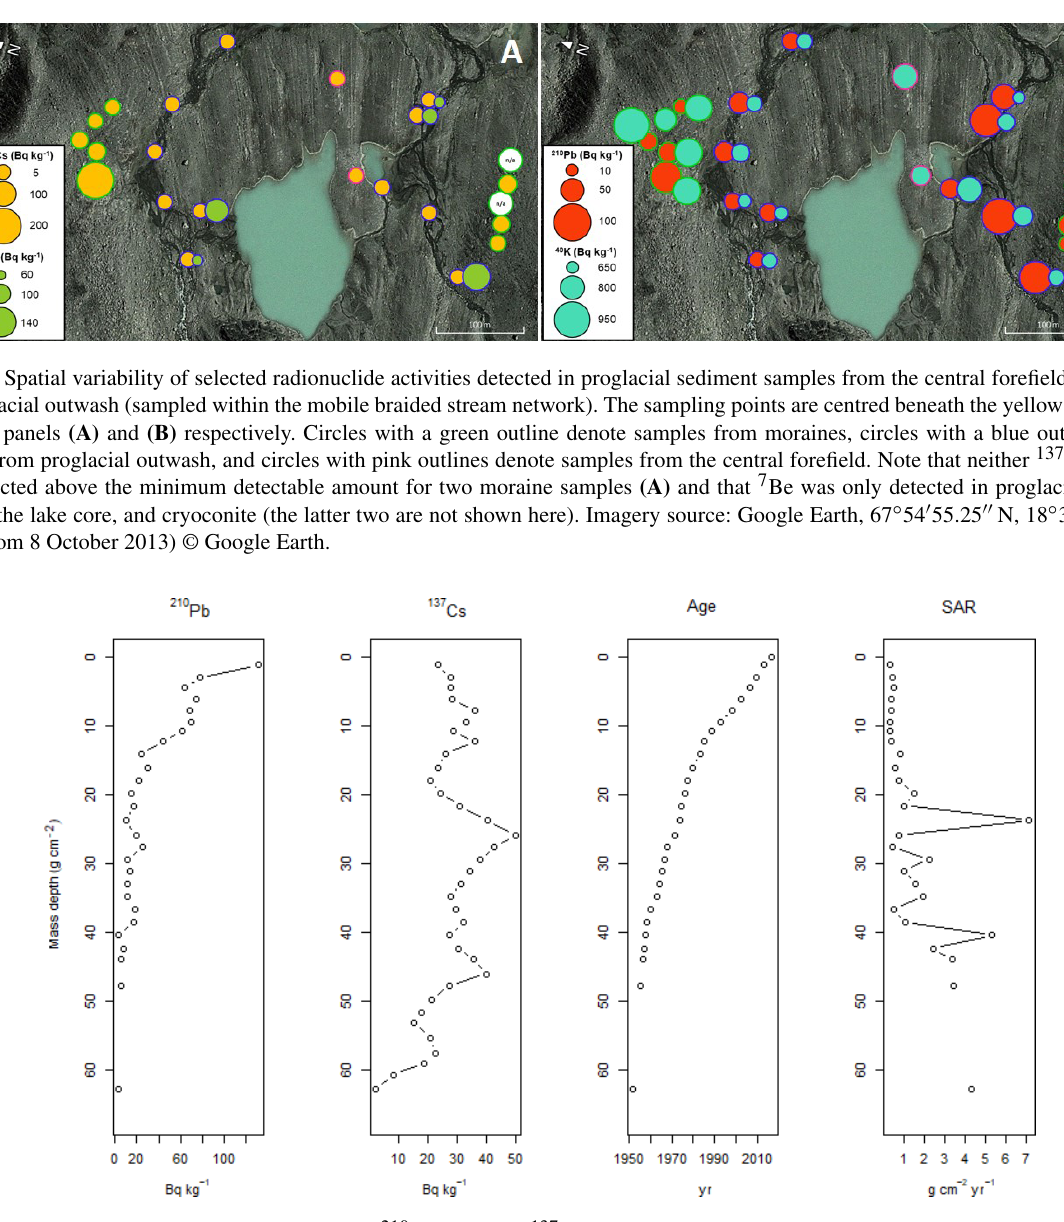
Figure 8. Fallout radionuclide depth profiles for (a) 210 Pb un and (b) 137 Cs with geochronological information of (c) age–depth and (d) sed- iment accumulation rate according to output from the constant rate of supply model (see text for